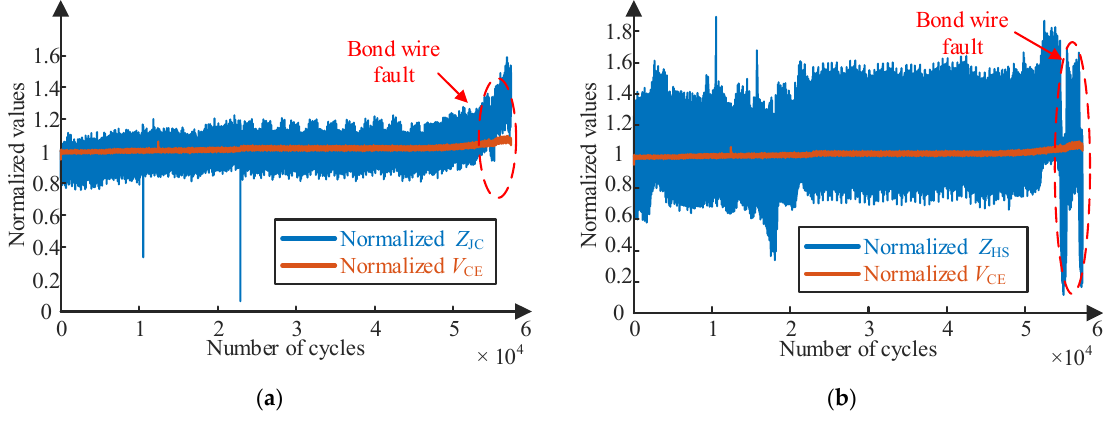
Figure 18. Normalized measured results of ( a ) IGBT module and ( b ) heatsink.